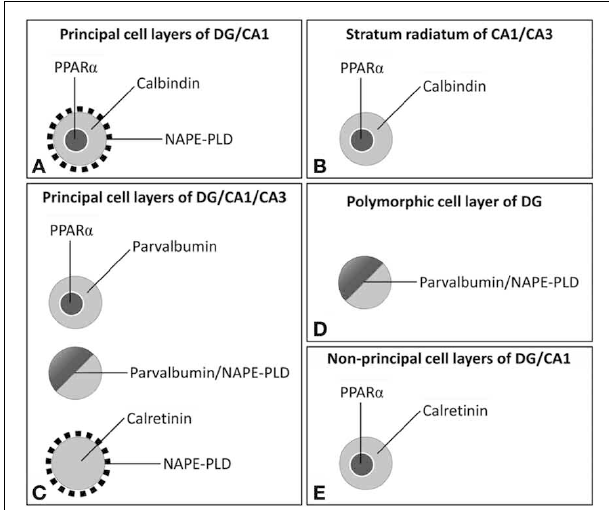
FIGURE 10 | Schematic representation of the main cell populations containing PPAR α /NAPE-PLD that expressed the CaBPs calbindin, calretinin, and parvalbumin in the different hippocampal regions. (A) Most dentate granular cells and some CA1 pyramidal cells co-expressed calbindin and nuclear PPAR α and were closely surrounded by NAPE-PLD + fiber varicosities. (B) Cells expressing both calbindin and PPAR α were also found in the SR of CA1/3. (C) In the principal cell layers of the DG and the CA1/3 fields, most cells containing parvalbumin expressed both NAPE-PLD and PPAR α , and the cell bodies that expressed calretinin, but most likely not PPAR α , were surrounded by NAPE-PLD + puncta. (D) Cells expressing both parvalbumin and NAPE-PLD were also found in the pcl of the DG. (E) A small number of PPAR α + cell bodies expressed calretinin, mainly in the non-principal cell layers of the